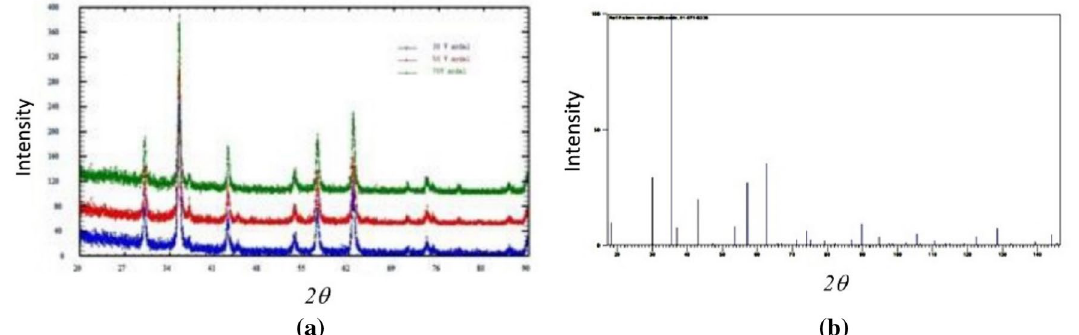
Figure 4. X-ray diffraction spectra of magnetite synthesized ( a ) at different applied voltages and the corresponding reference spectrum (JCPDS No. Card 01-071-6336) ( b